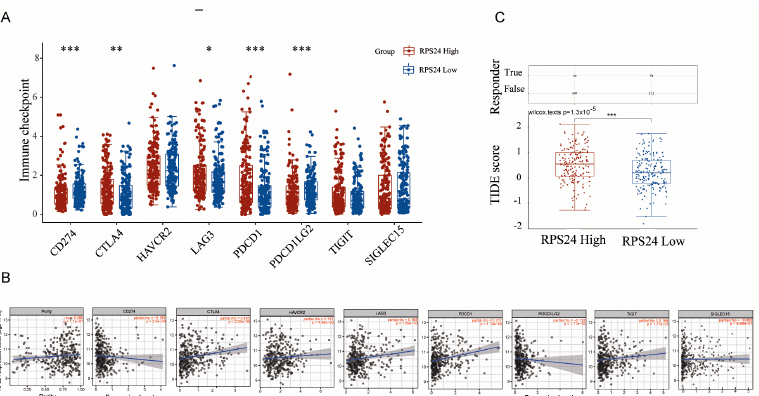
Figure 8. Correlation of RPS24 with immune checkpoint molecules and immunotherapy response. ( A ) The immune checkpoint molecules were measured in HCC patients in the low- and high-RPS24 groups using the TCGA-LIHC data. ( B ) The relationship between RPS24 expression and immune checkpoint molecules was measured using the TIMER database. ( C ) TIDE scores were measured in HCC patients in the low- and high-RPS24 groups using the TCGA-LIHC data. * p < 0.05; ** p < 0.01; *** p < 0.001.